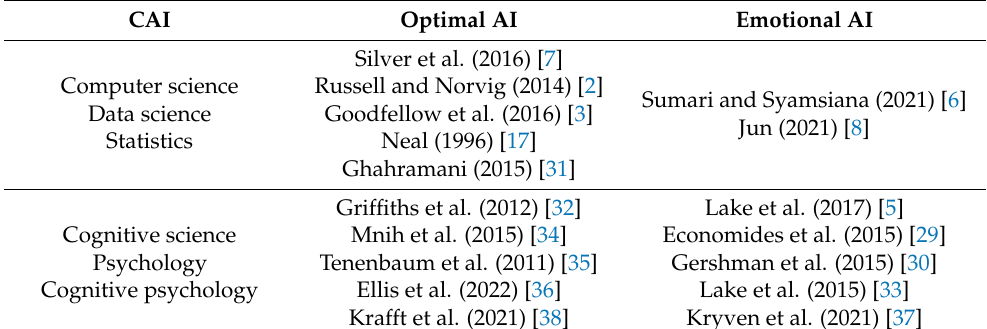
Table 1. Existing research results of optimal and emotional AI according to computer and cogni- tive